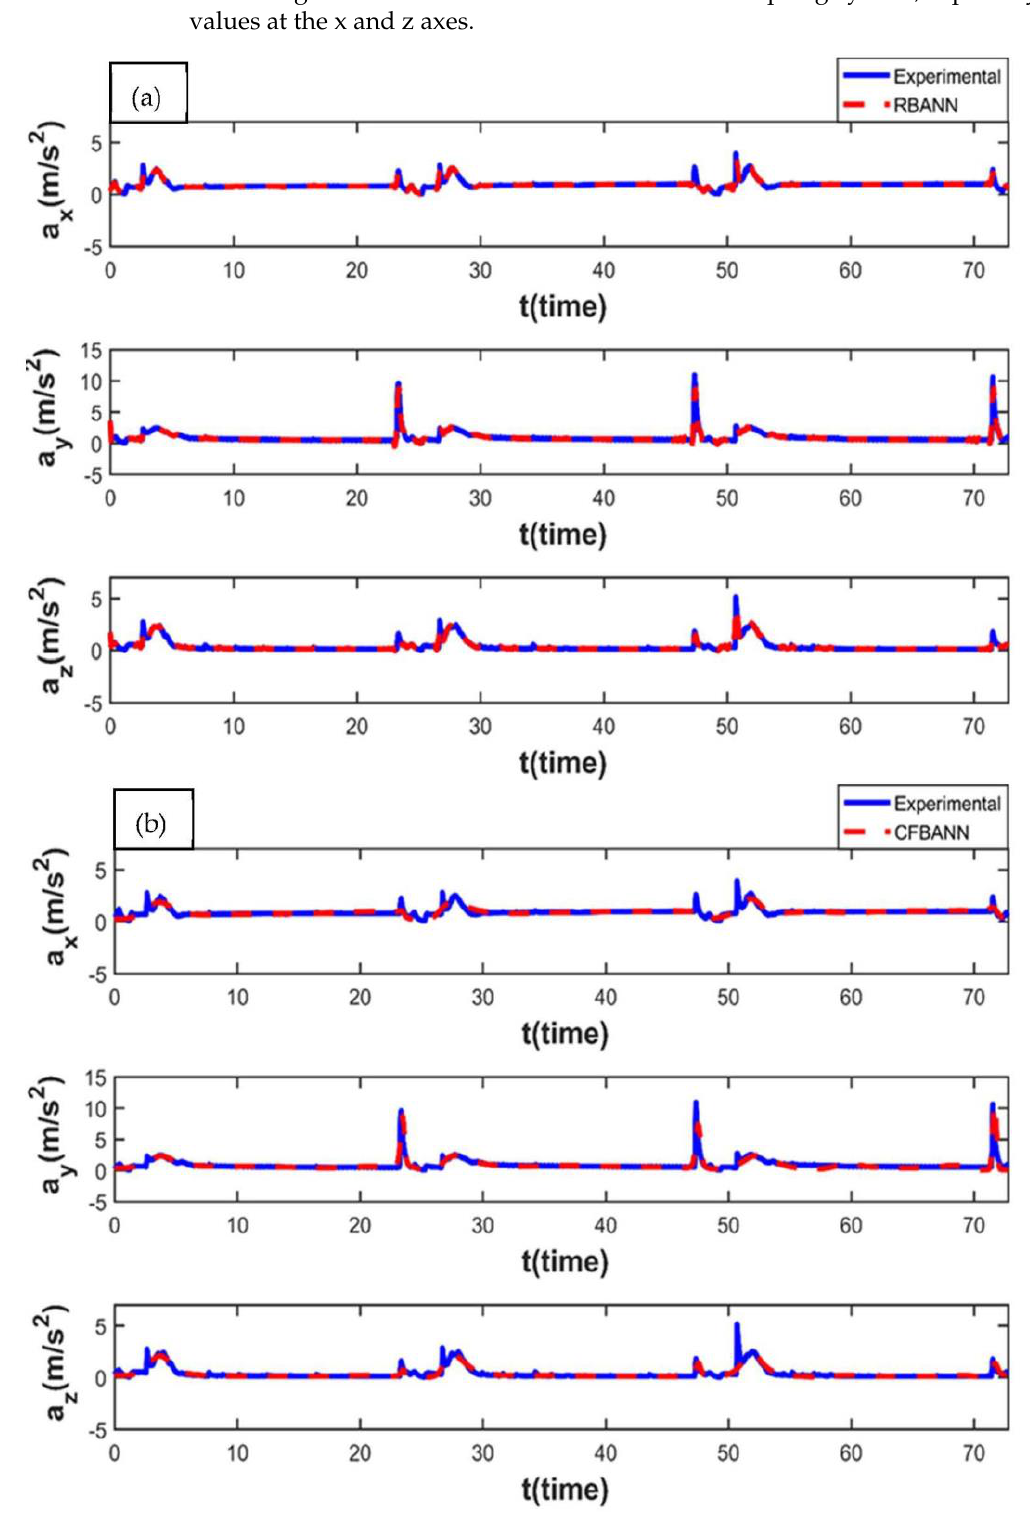
Figure 15. Experimental and ANN results obtained for the working condition of 20 s and 18.75 bar: ( a ) RBANN; ( b ) CFBANN.